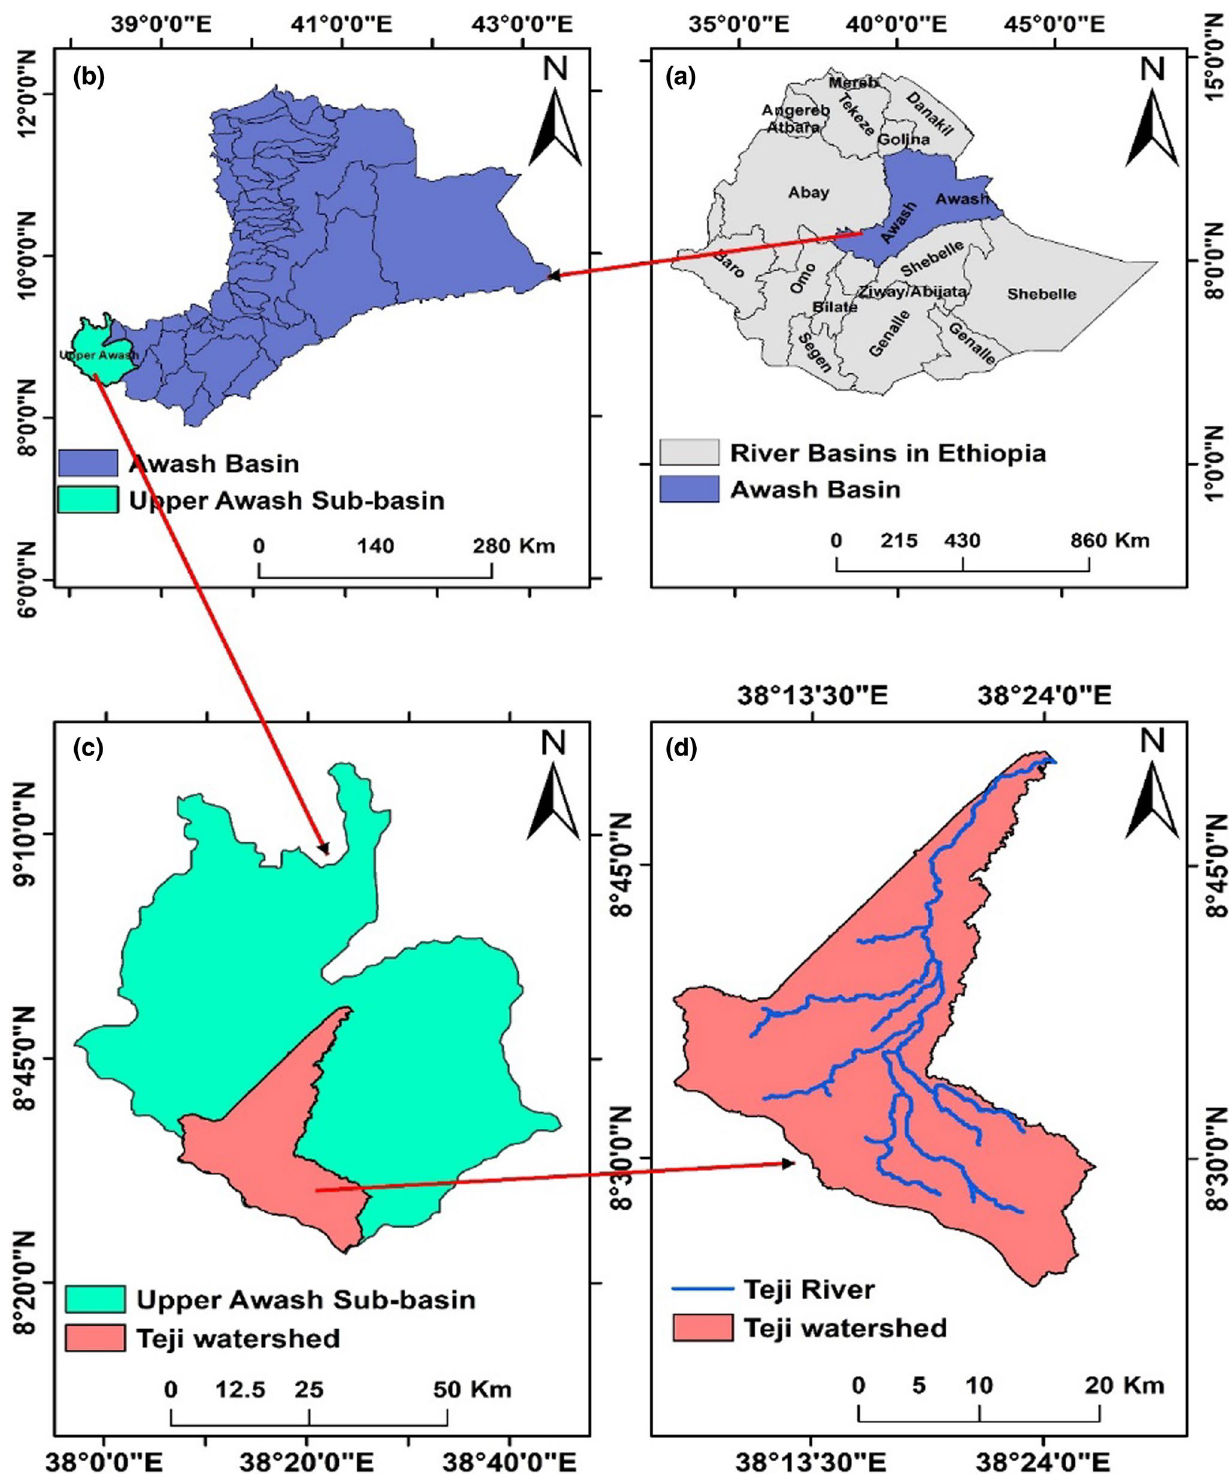
Figure 1 Location of the study area a River basins in Ethiopia, b Awash river basin, c Upper Awash sub-basin and d Teji